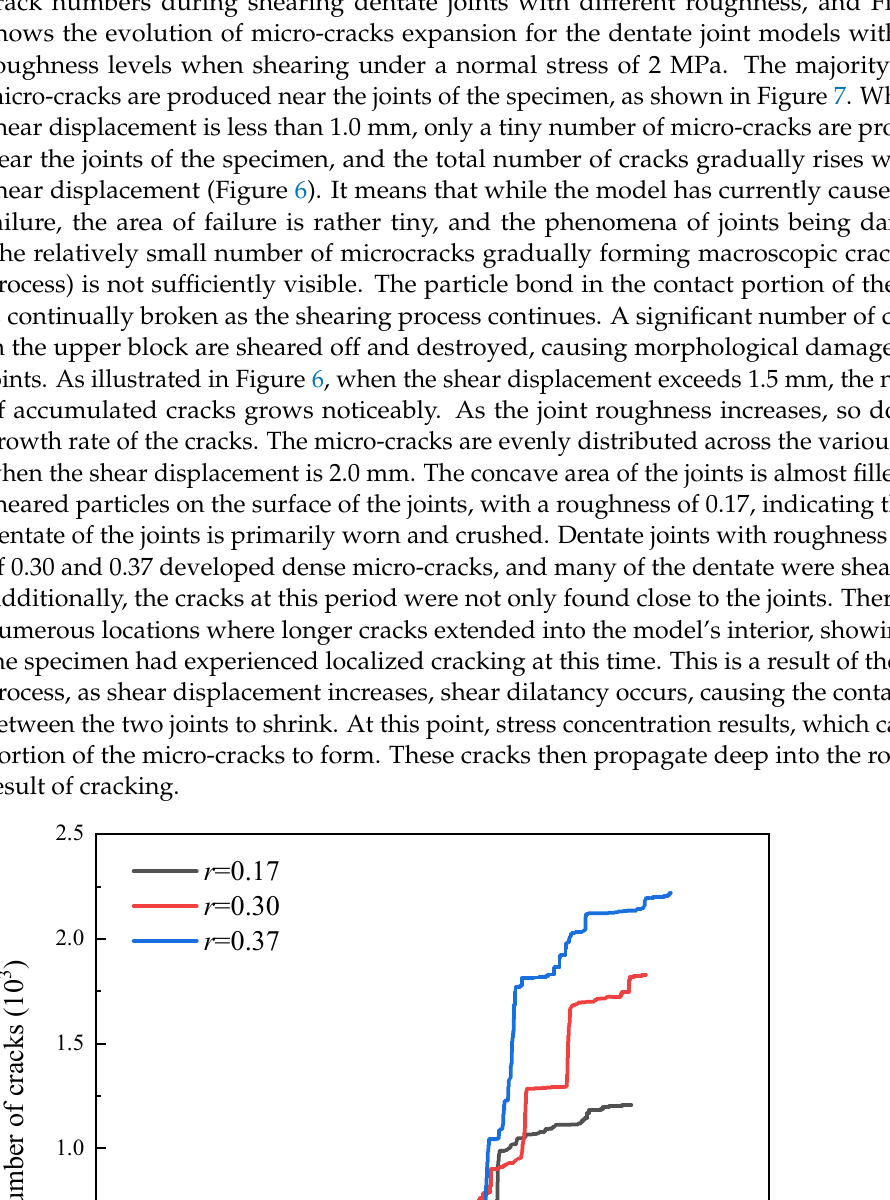
8 of 19 Figure 5. Normal displacement versus shear displacement curve of dentate joints with different roughness. 2.4. Shear Damage Evolution Characteristics of the Dentate Joints The crack evolution characteristics of dentate joints during the simulated shear test were dynamically tracked to explore the shear deformation failure characteristics of den- tate joints with varied roughness. Figure 6 depicts the variation curves of the accumulated crack numbers during shearing dentate joints with different roughness, and Figure 7 shows the evolution of micro-cracks expansion for the dentate joint models with three roughness levels when shearing under a normal stress of 2 MPa. The majority of the mi-